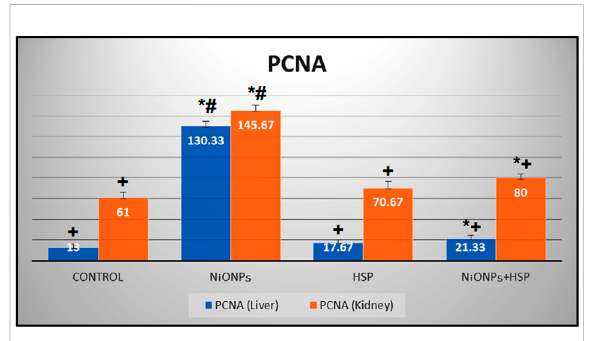
FIGURE 10 A bar graph showing a signi fi cant increase in the number of PCNA-positive immune-reactive cells within the liver and kidneys of NiO-NPs-exposed rats compared to Control and HSP supplemented rats ( p < 0.05 ). Coadministration of HSP with NiO-NPs (Group IV) resulted in a signi fi cant decrease in the number of PCNA-positive immune-reactive cells compared to NiO-NPs group (Group II) ( p < 0.05 ).Data are presented as mean values ±SD. * : Signi fi cantly different from Control group. +: Signi fi cantly different from NiO-NPs group. #: Signi fi cantly different from HSP group. Statistical signi fi cance level at p < 0.05